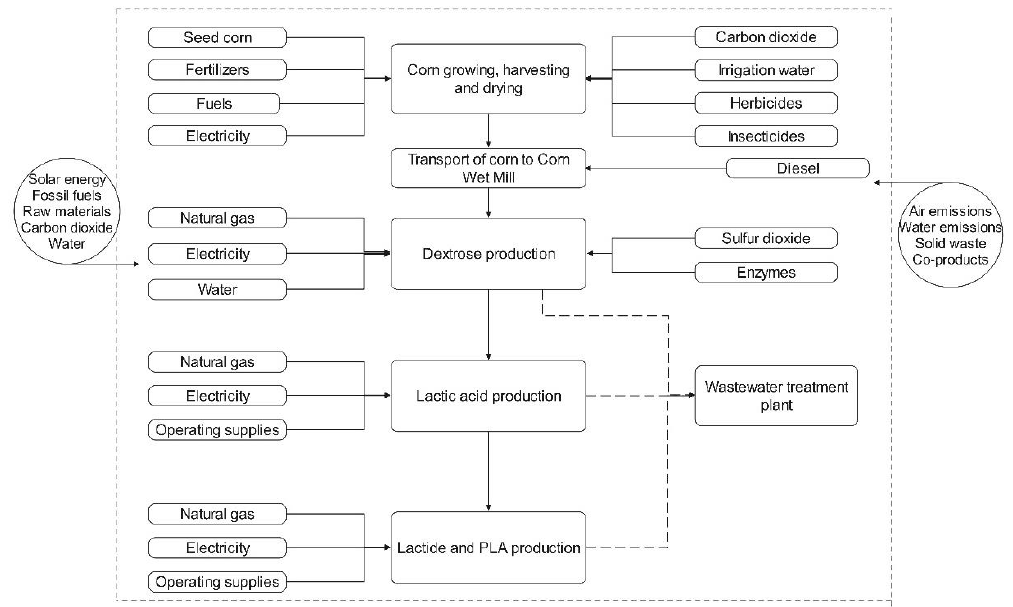
Figure 9. Simplified flow diagram of the life cycle Cargill Dow process for lactide and PLA production (reprinted with permission [72], Copyright 2003 Elsevier).